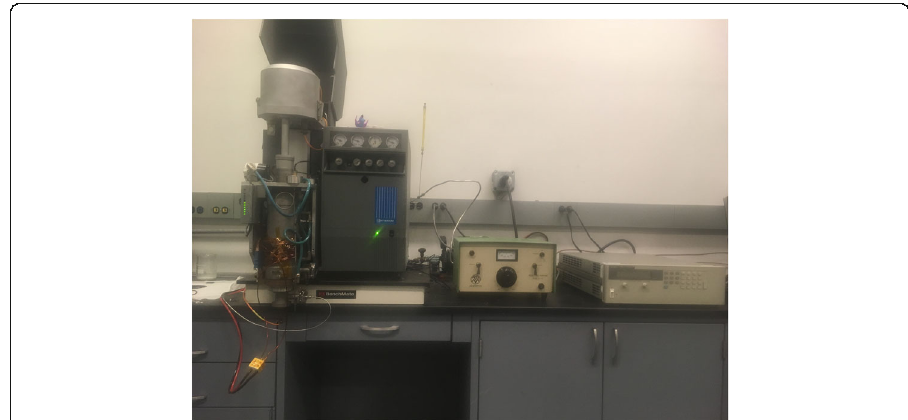
Fig. 2 The modified Setaram DSC/TGA with exposed column showing magnet and wires to Agilent power supply on the far